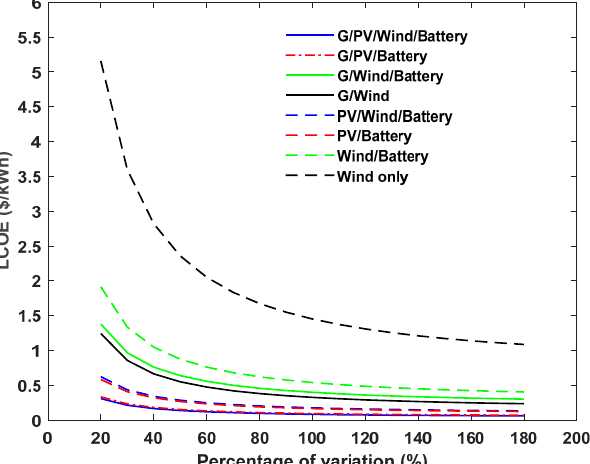
Figure 10. Influence of the variation in the project lifetime on the LCOE of the studied systems. Energies 2023 , 16 , x FOR PEER REVIEW